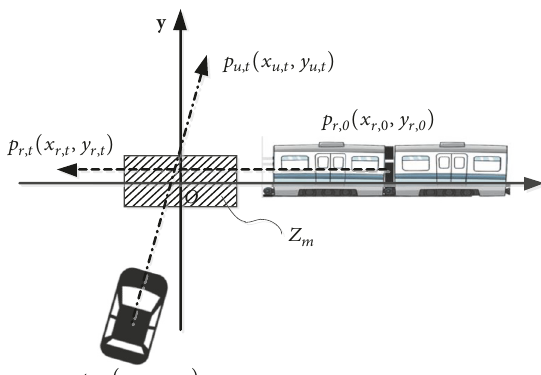
Figure 2: Kinematic